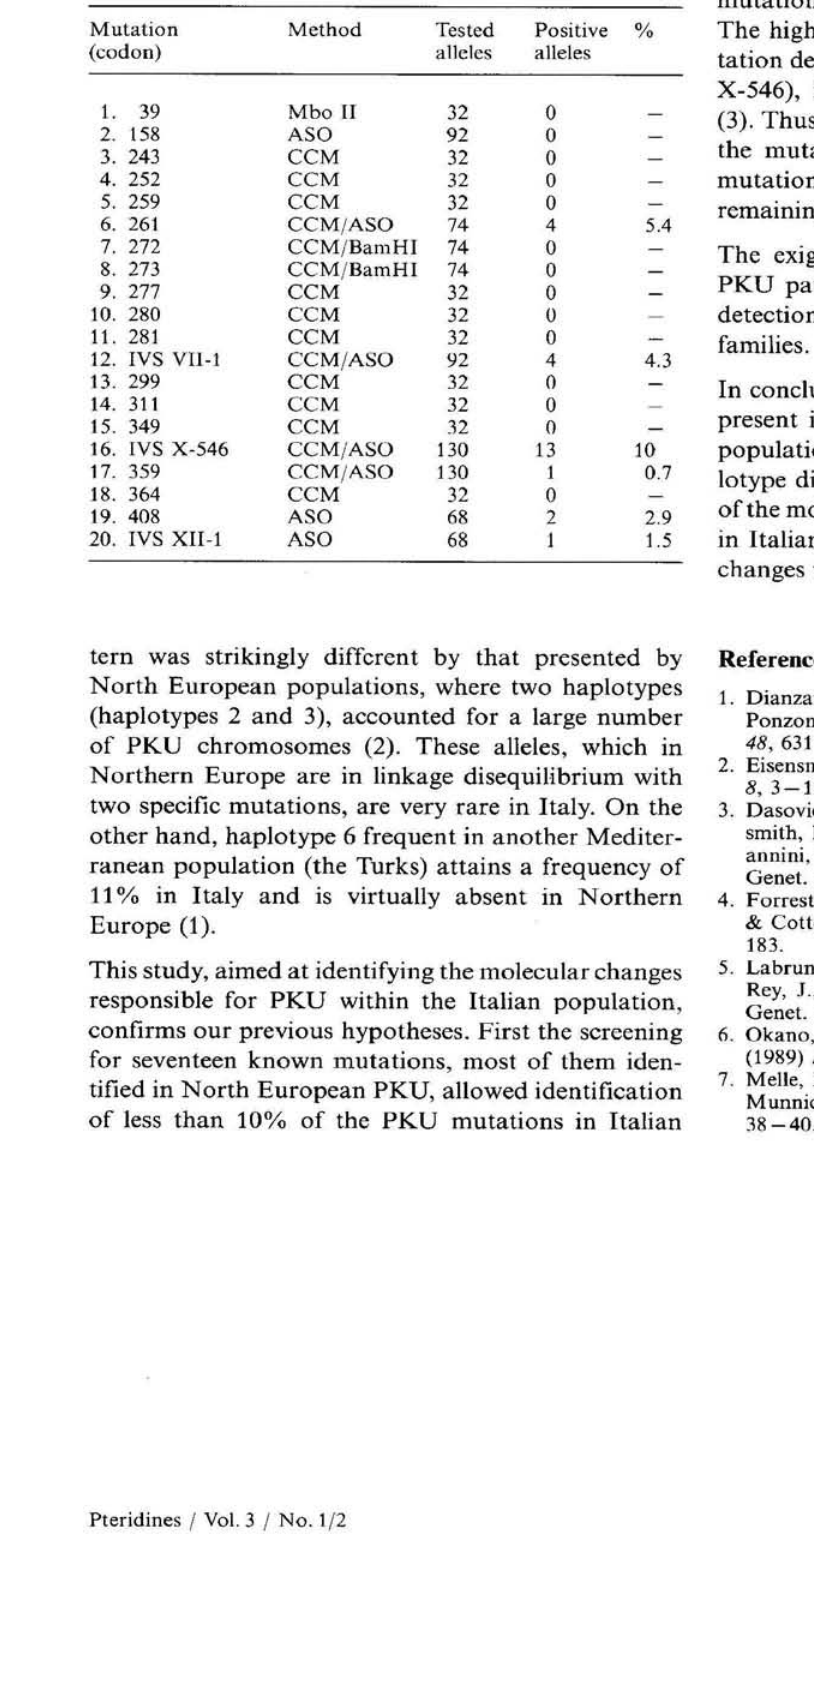
Table 1. Mutations analysed in the Italian population within the present study. The exact references for mutations 2, 3, 4, 6, 7, 10, 11, 14, 18, 19 and 20 are reported in ref. 2; mutations 1 and 15 are reported in ref. 4;'mutations 5 and 9 are reported in ref. 5; mutations 8 and 13 were reported respectively in ref. 8 and 7. References for the remaining mutations have been cited in the